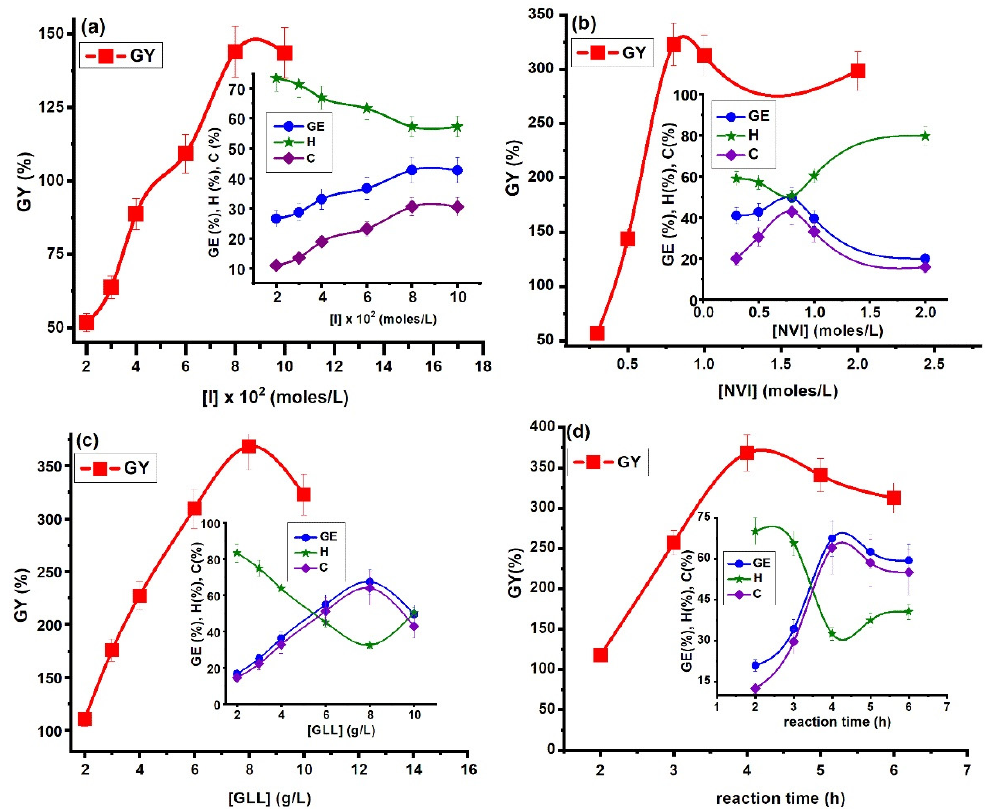
Figure 2. Influence of various factors on grafting parameters: ( a ) initiator concentration (c m = 0.5 mol/L; c p = 10 g/L, T = 60 °C and t = 4 h); ( b ) monomer concentration (c i = 0.08 mol/L, c p = 10 g/L, T = 60 °C and t r = 4 h); ( c ) gellan concentration (c i = 0.08 mol/L; c m = 0.8 mol/L; T = 60 °C and t r = 4 h); ( d ) reaction time (c i = 0.08 mol/L; c m = 0.8 mol/L; c p = 8 g/L; T = 60 °C).